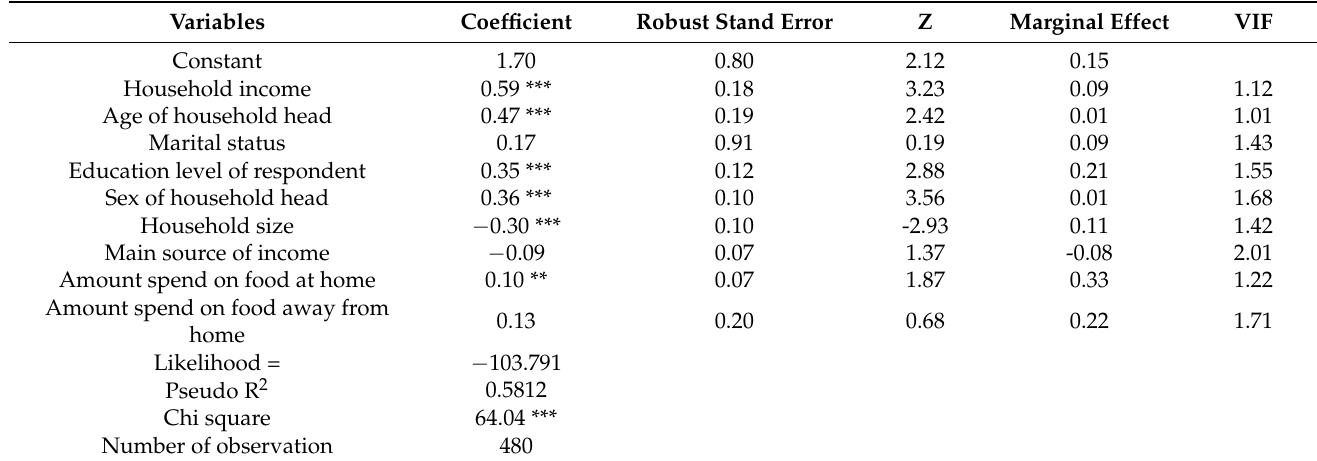
Table 10. Maximum likelihood estimates of probit